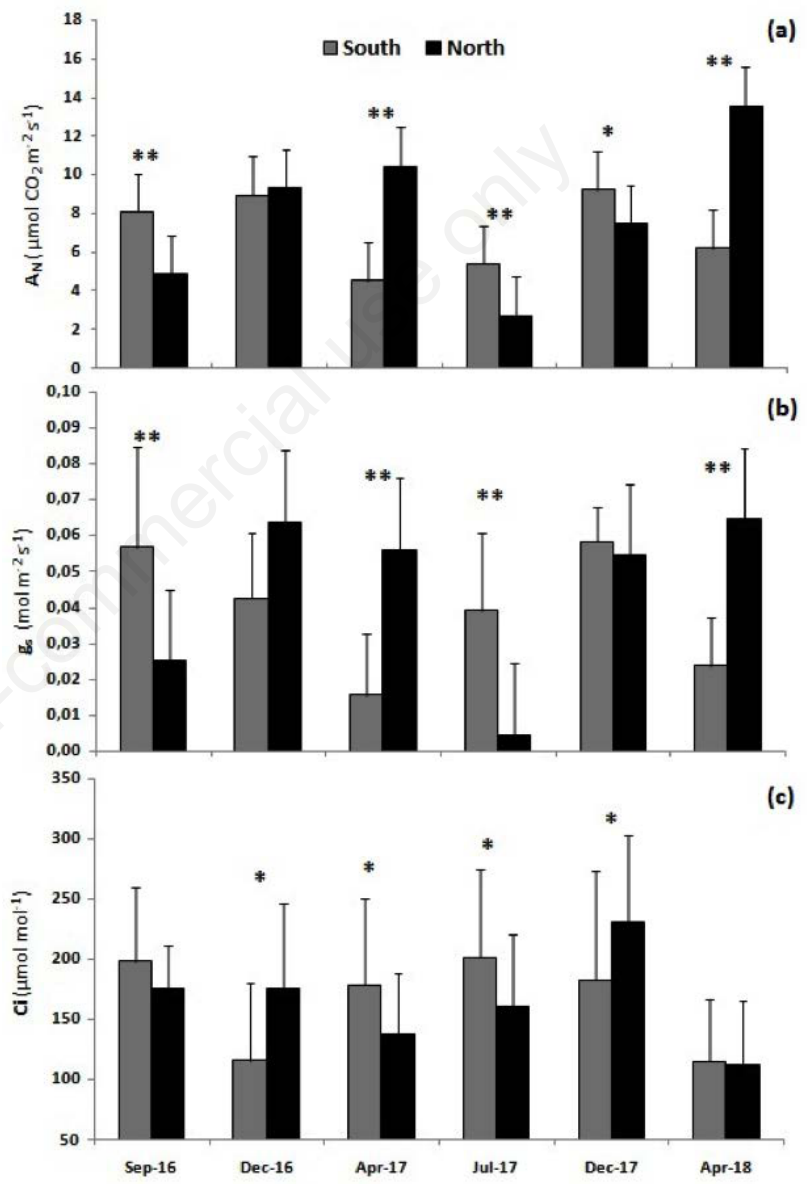
Figure 2. Net photosynthetic rate, AN (a), stomatal conductance, g lular CO concentration Ci (c) in randomly selected leaves of A. spinosa in the North and 2 the South. Values represent mean ± SE, n=30 for A, gs, and Ci. Asterisks indicate signif- icance levels for the comparison between the two sites within each season by student’s t- tests (**P<0.001;